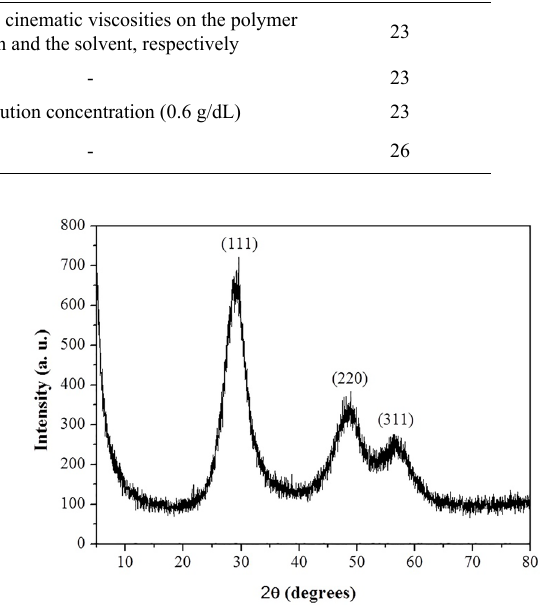
Table 1. Equations used for viscosity measurements. Viscosity measurement